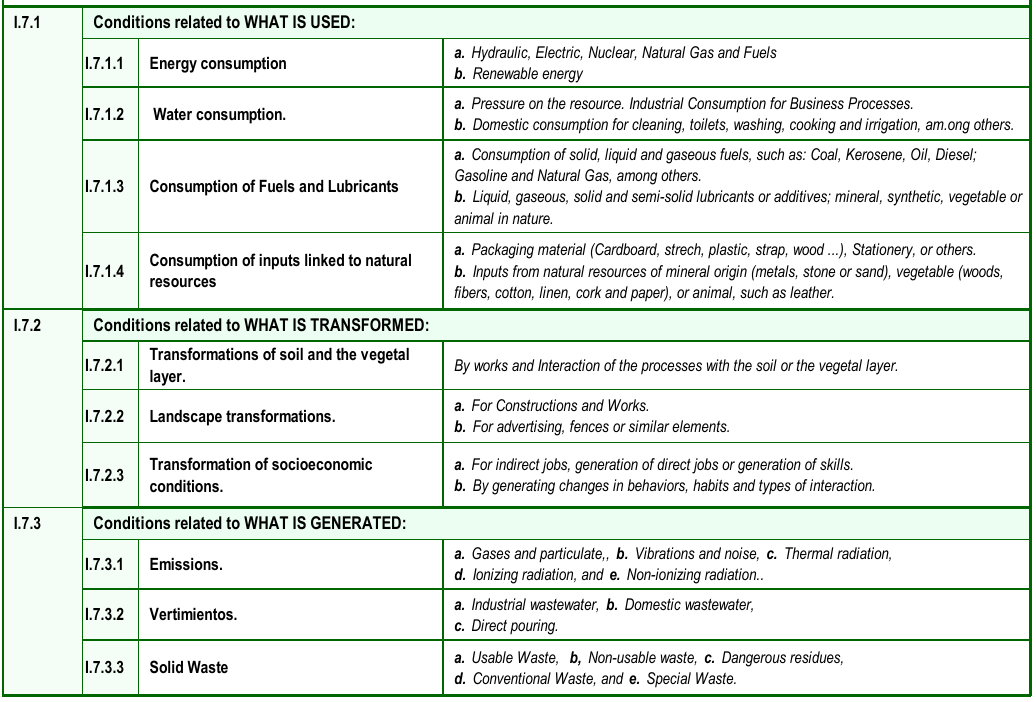
Figure A12. Classification matrix of topics related to internal R / O. Layer IV: I.7. [27,40,47,56].